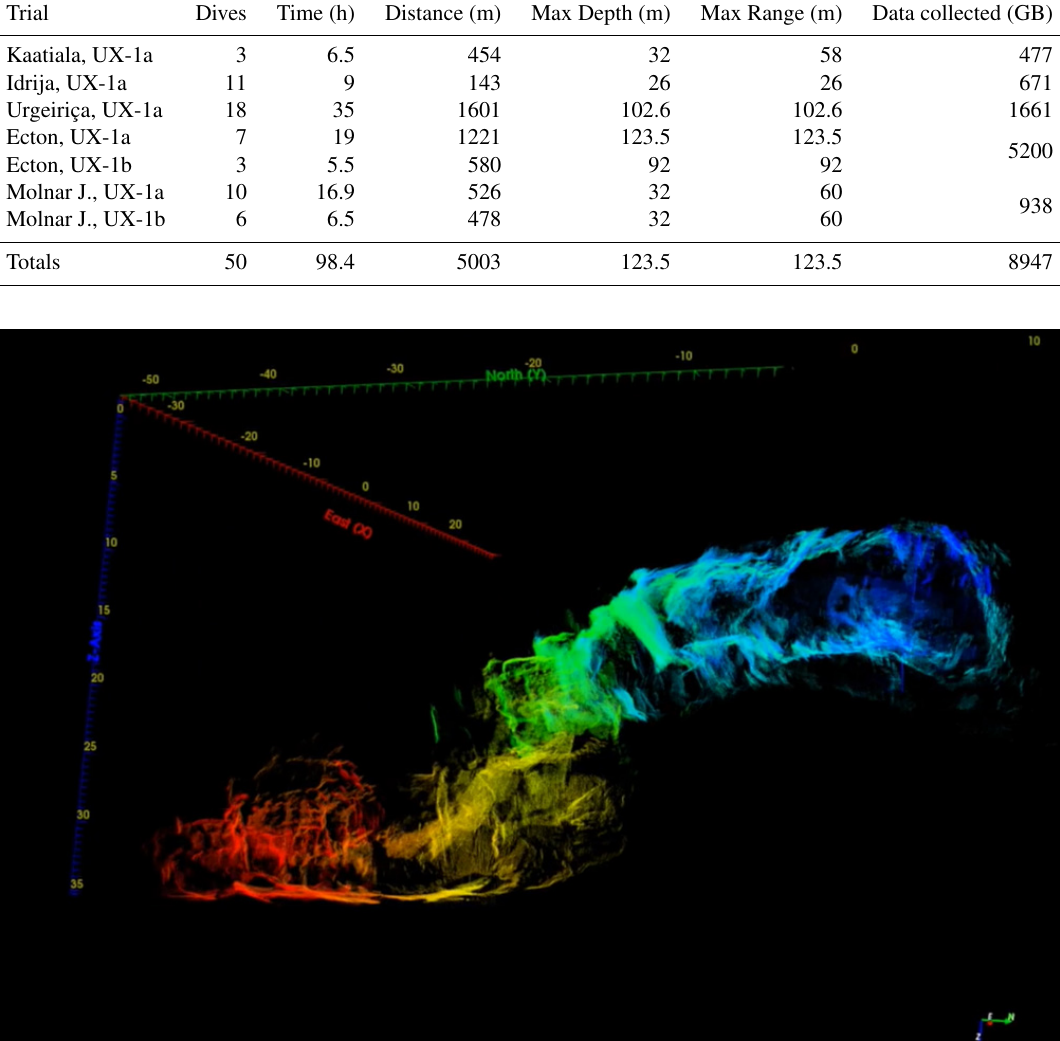
geologists are able to build geological maps and